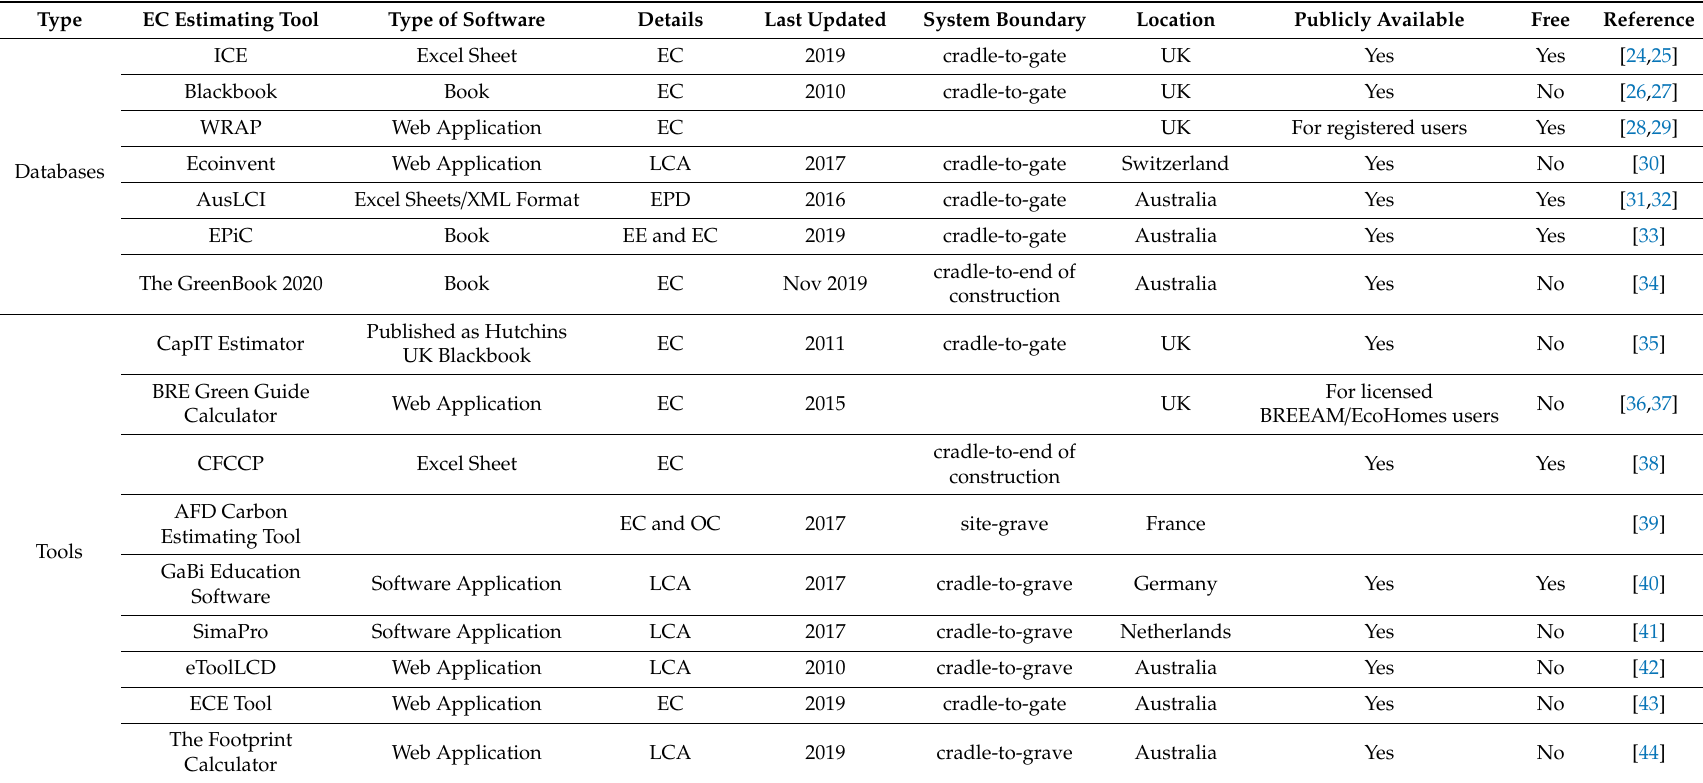
Table 1. Summary of the embodied carbon estimating databases and tools After